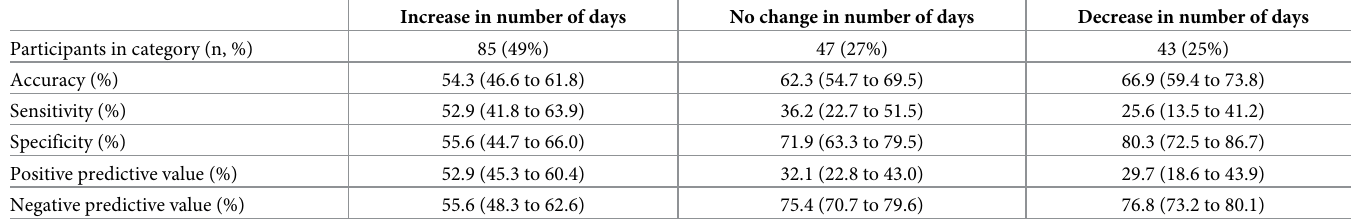
Table 3. Binary classification tests for the single item measure versus accelerometer for detecting increase, decrease and no change in number of days � 60 minutes MVPA from Week one to Week